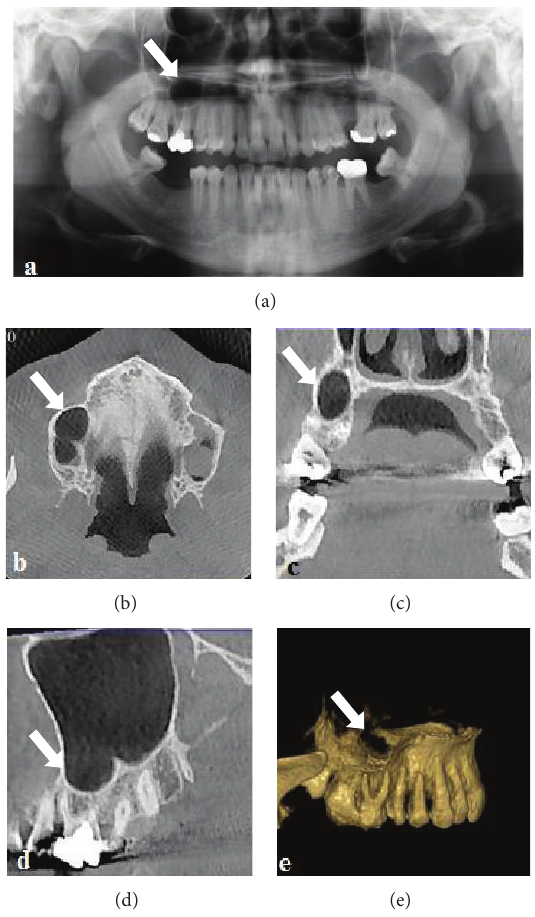
Figure 1: Panoramic radiograph showing well-defined periapical radiolucency in relation to maxillary first molar, extending to involve the root of canine and suggestive of a periapical cyst (a). Axial (b), coronal (c), sagittal, and three dimensional view of the aberrant anatomical variation of maxillary sinus.